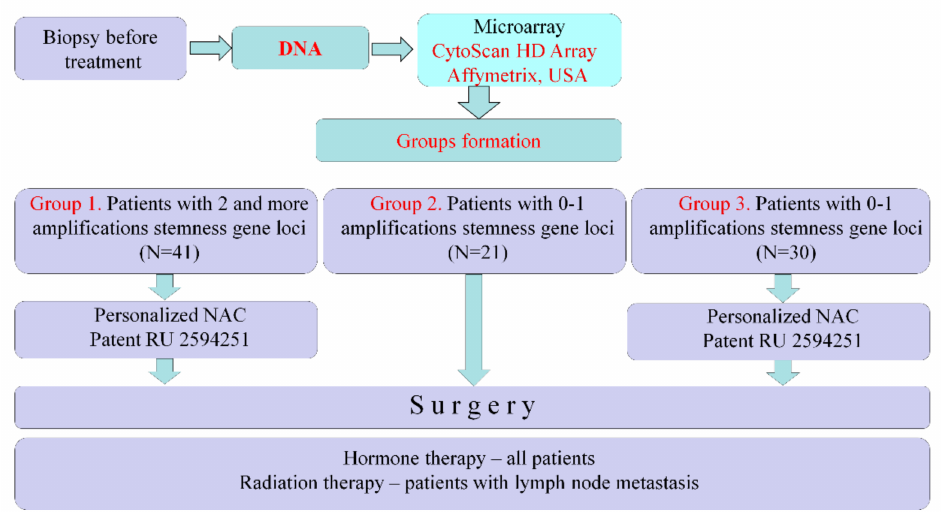
Figure 1. Prospective study